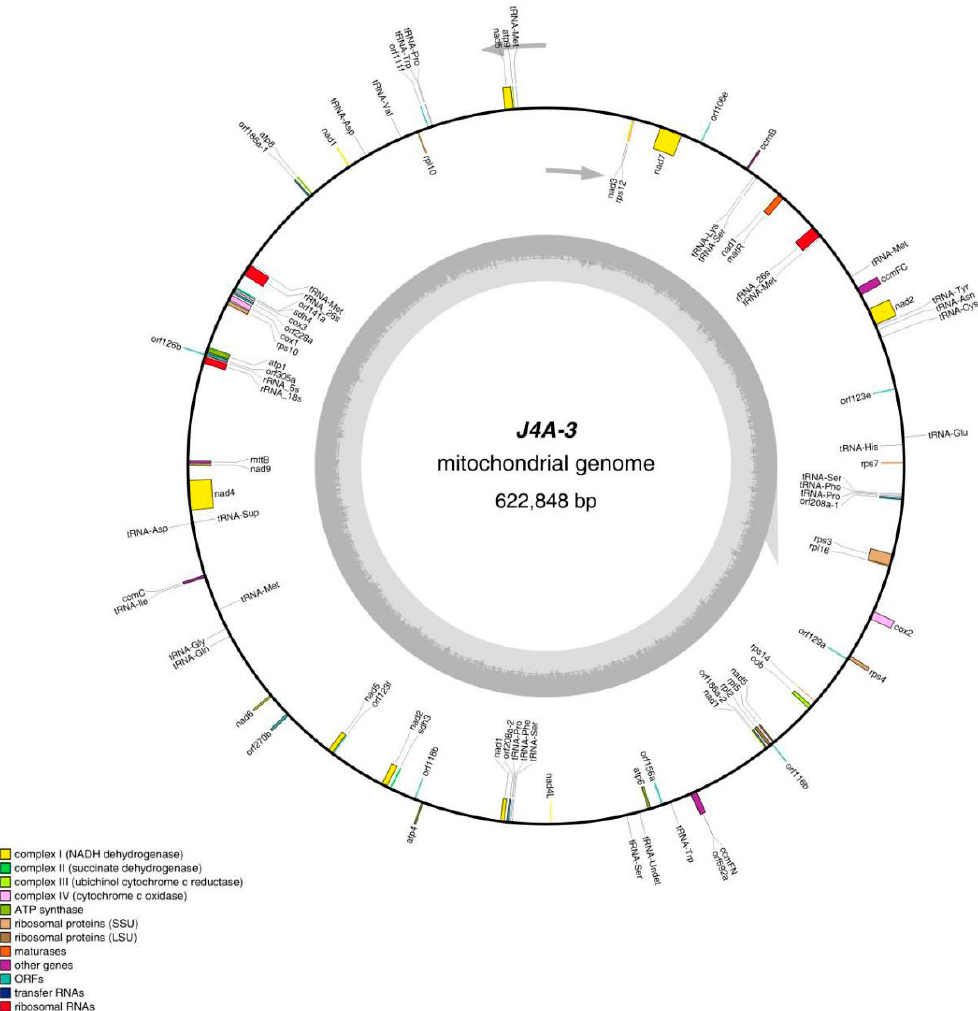
Figure 1. Physical map of the mt genomes of the cytoplasmic male sterility (CMS) line J4A-3. Note: The outer circle represents the physical map scaled in kilobase pairs. Different colors indicate different genes as defined in the legend shown in bottom left of the figure: yellow, NADH dehydrogenase; green, succinate dehydrogenase; light green, ubiquinol cytochrome c reductase; pink, cytochrome c oxidase; chartreuse, ATP synthase; tan and brown, ribosomal proteins; orange, maturase; purple, other genes; turquoise, open reading frames (ORFs); dark blue, transfer RNAs; dark red, ribosomal RNAs. Table 2. Gene contents of cotton Table 1. The assembled features of the mt genomes.